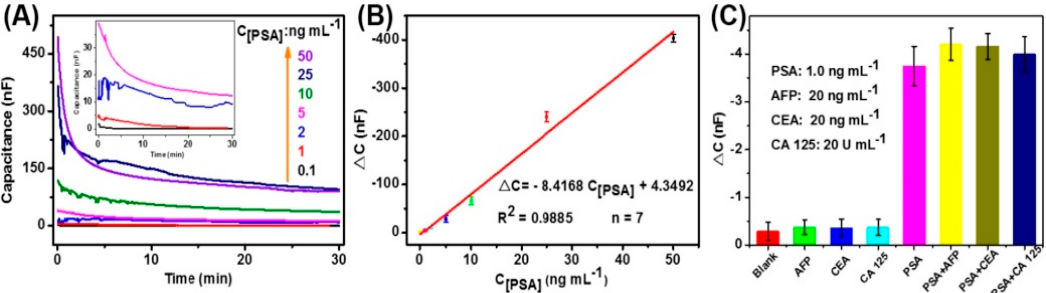
Figure 7. Analytical performance of the developed immunoassay ( A ) capacitance responses of Ti 3 C 2 MXene-based interdigitated immunosensor toward target PSA standards; ( B ) the corresponding calibration plots; and ( C ) the specificity of capacitance immunosensor against target PSA and non-targets including AFP, CEA, and CA 125 (reproduced with permission from reference [86]).